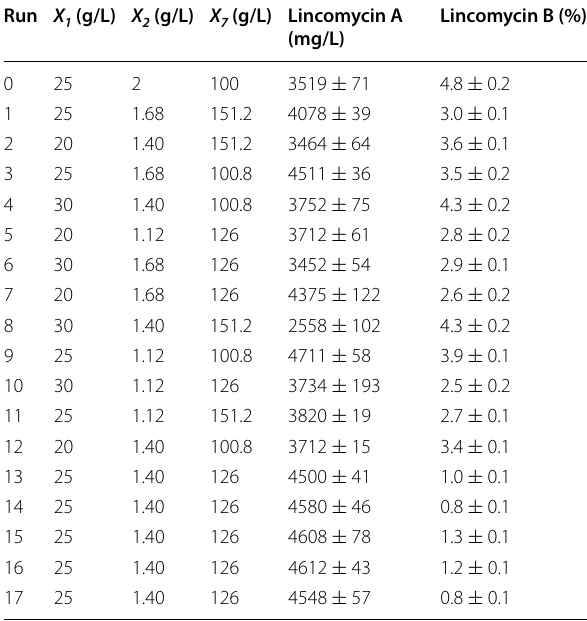
The values were obtained from three independent experiments. X1 soybean powder, X2 corn steep liquor, X3 NaCl, X4 NaNO3, X5 KH2PO4, X6 (NH4)2SO4, X7 glucose, X8